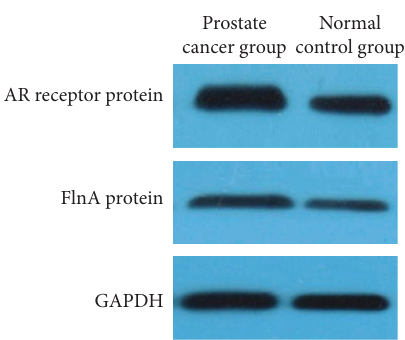
Figure 2: Expression of androgen receptor silk protein A